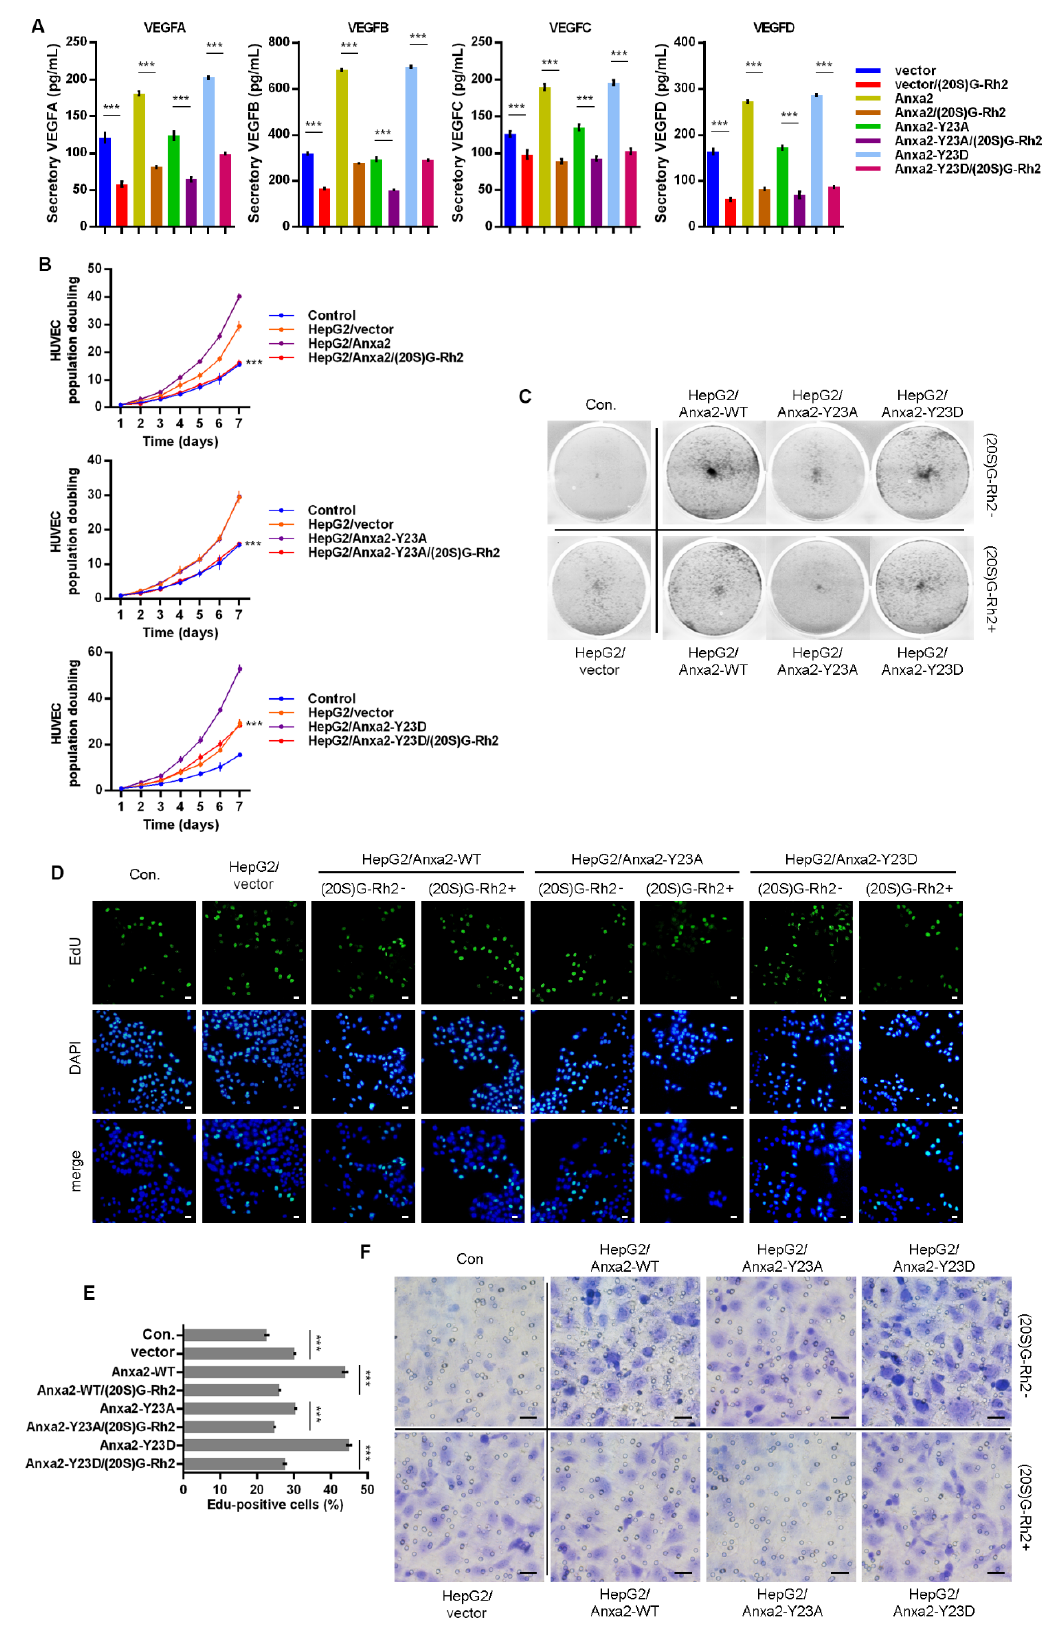
Figure 6. (20S)G-Rh2 inhibited Anxa2-Y23D mutant-enhanced proliferation and migration of HUVECs. Myc-tagged wild-type, Y23A mutant and Y23D mutant of Anxa2 was over-expressed in HepG2 cells. ( A ) The concentration of four VEGFs